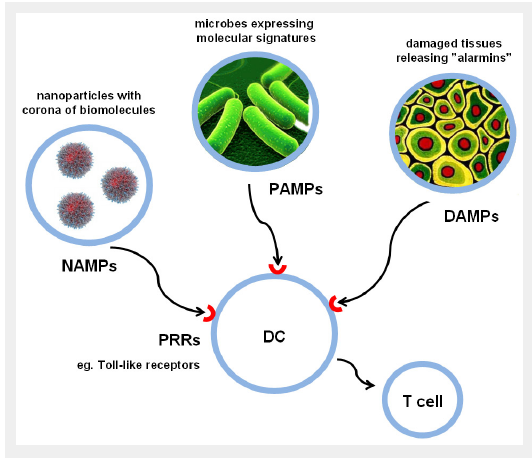
Do nanoparticles act as danger signals and/or display such signals on their surface? In this hypothetical diagram, the analogy is made between pathogens (microorganisms) that display pathogen- associated molecular patterns (PAMPs) and damaged or stressed tissues that release damage-associated molecular patterns (DAMPs), such as HMGB1, a non-histone nuclear protein that acts as a secreted alarmin, and engineered nanoparticles that are coated with a bio-corona of proteins, possibly unfolded, thereby revealing hidden epitopes, that may act as nanomaterial-associated molecular patterns (NAMPs). These molecular signatures are recognised by so-called pattern recognition receptors or PRRs – including the Toll-like receptors – on the surface of innate immune cells or expressed within such cells. The activation of PRRs triggers inflammation and alerts the adaptive immune system to impending danger